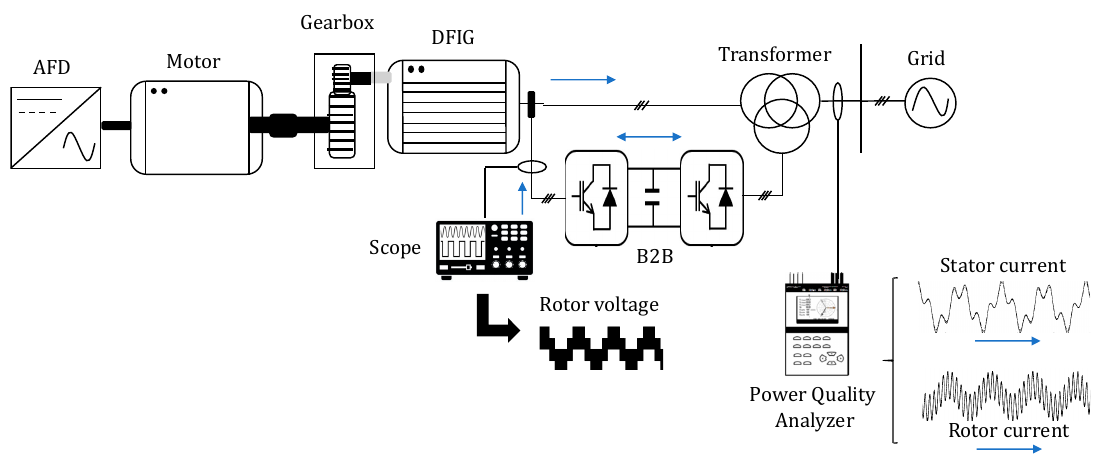
Figure 9. Block diagram of the experimental setup.